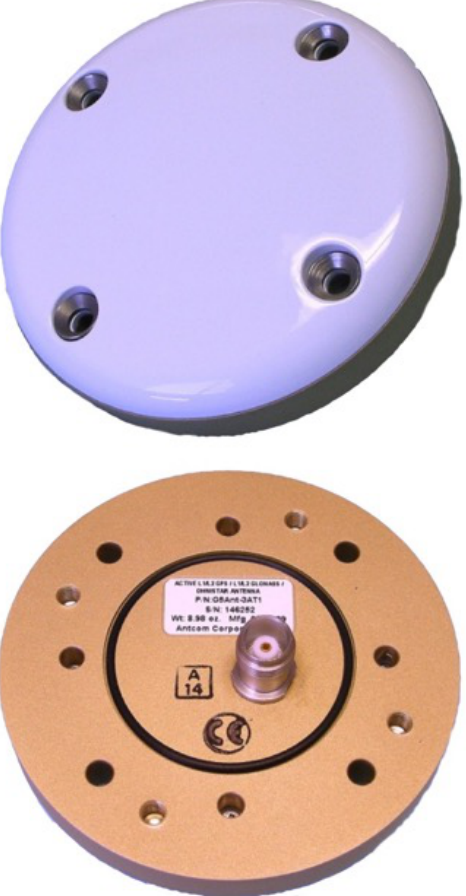
Figure 6. Model of satellite signal receptors adapted for geo- physical survey aircrafts (source: modified from Product Draw- ing, GPS Source, http://www.gpssource.com/products/search/160, March 2015).